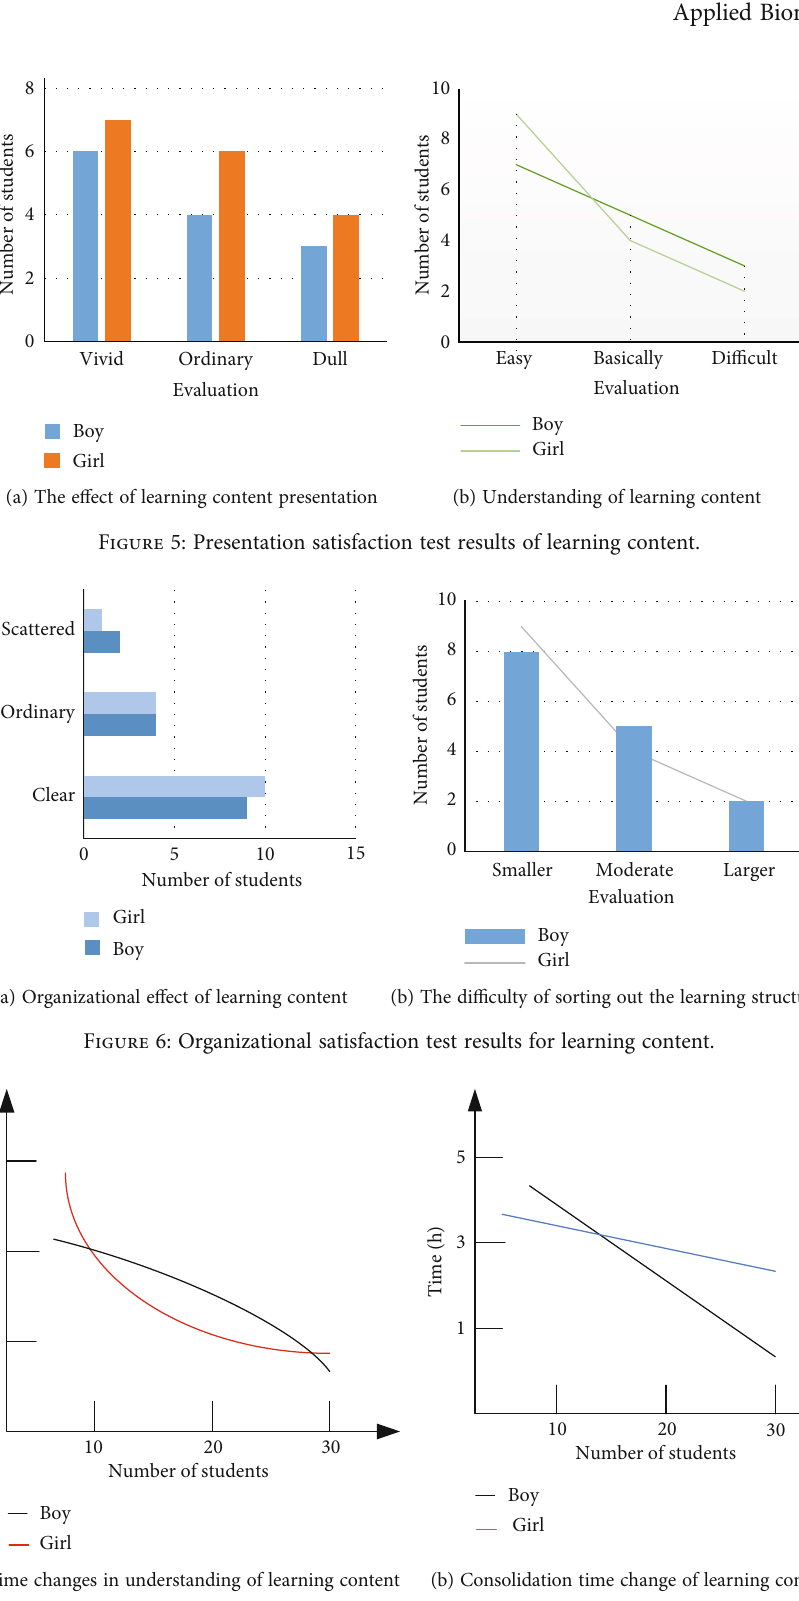
Figure 7: Student ’ s learning e ffi ciency change test